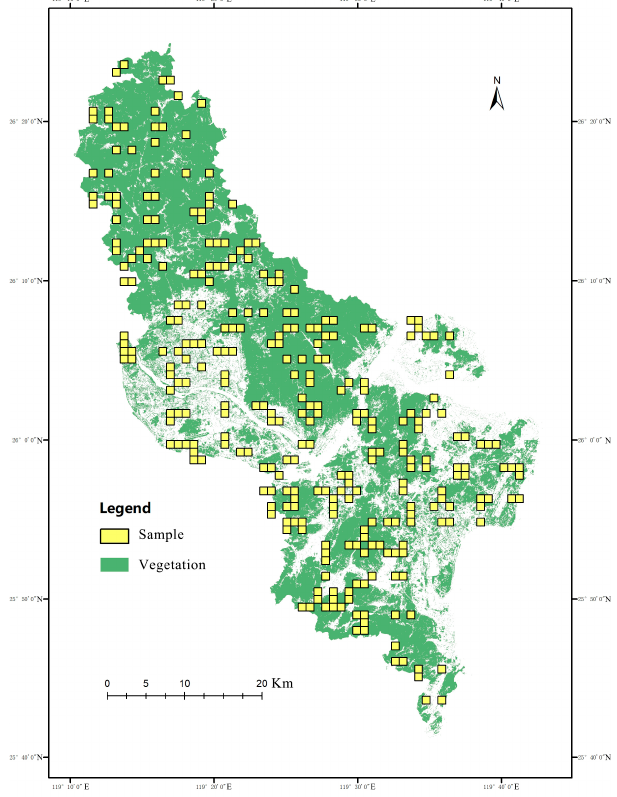
Figure 8. Green space landscape unit sample of Fuzhou City.